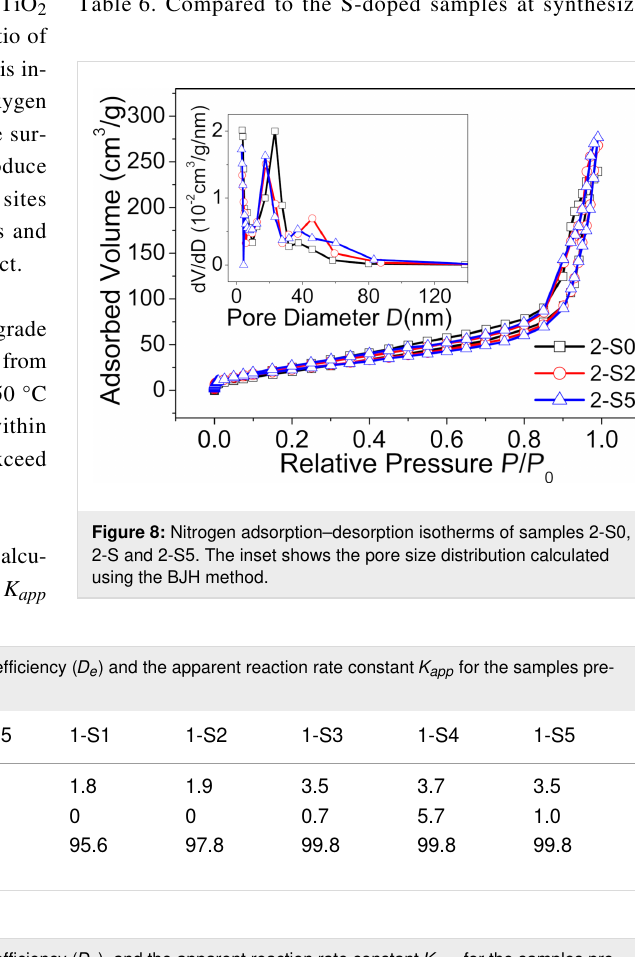
Table 5: The values of the adsorption efficiency ( A e ), degradation efficiency ( D e ), and the apparent reaction rate constant K app for the samples pre- pared at 250 °C and for P25 TiO 2 . sample